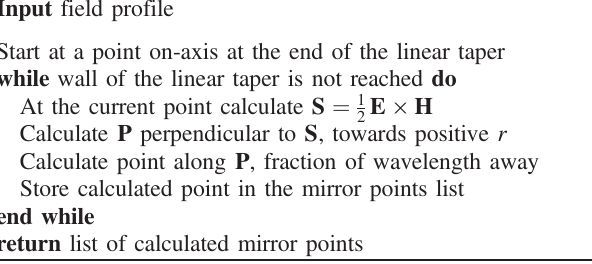
Algorithm 1. Mirror fitting algorithm, adapted from Toufexis et al.